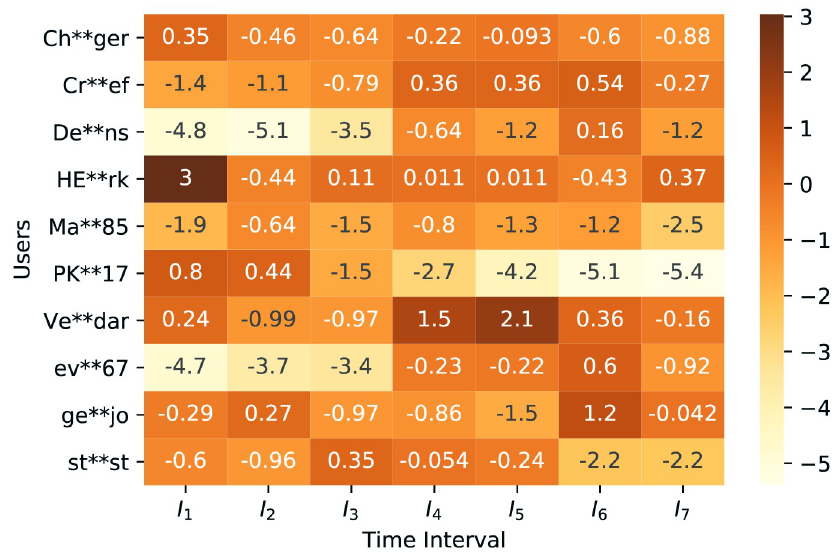
Fig 7. Heatmap of selected ten users sentiment dynamics at each time-interval I selected ten users at different seven time-interval).